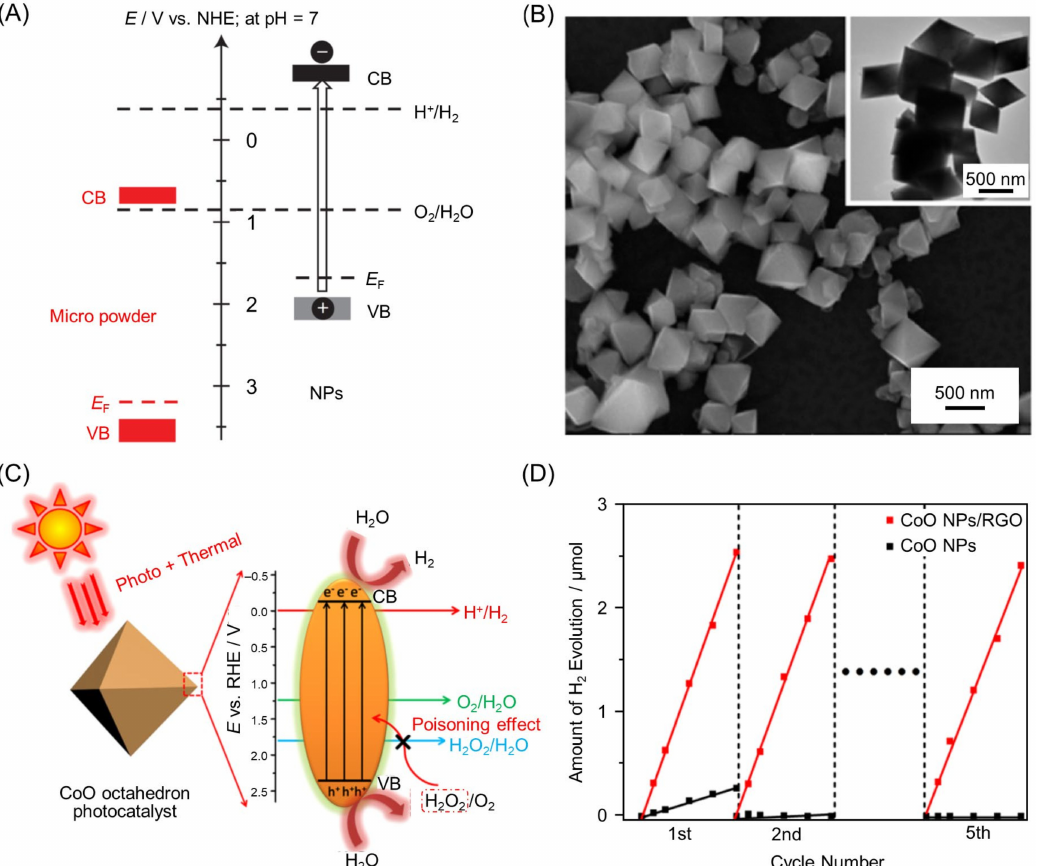
Figure 11. ( A ) Band positions of CoO micropowders and NPs. ( B ) Scanning electron microscopy (SEM) image of CoO octahedra (inset, transmission electron microscope (TEM) image). ( C ) Mech- anism of overall water splitting over CoO octahedron photocatalyst. ( D ) Cycle stability of H 2 evolution from pure water under Vis-light irradiation ( λ > 400 nm) using CoO/reduced graphene– oxide (RGO) composite and CoO octahedra (each cycle is 24 h). Reproduced with permission